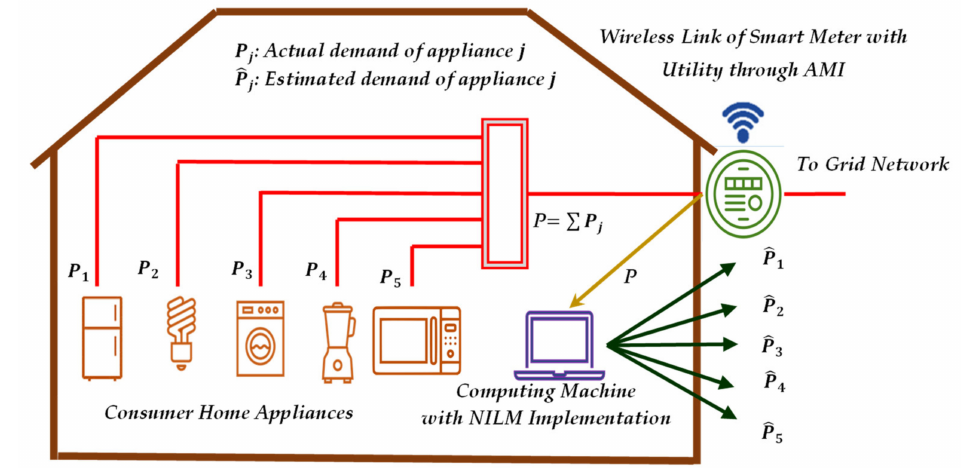
Figure 2. Illustration of the general NILM